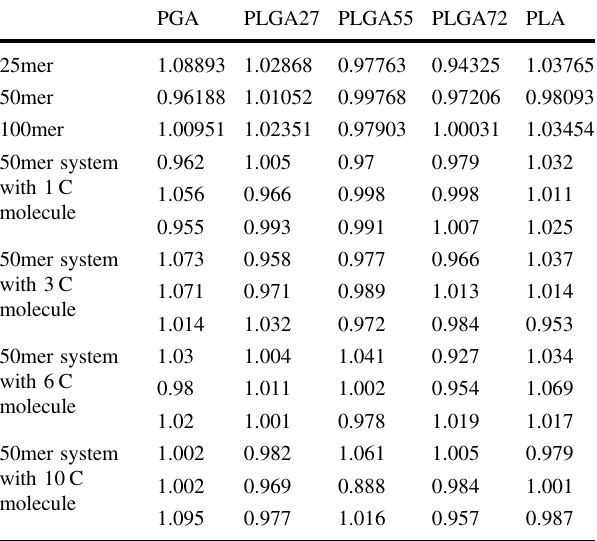
Table 3 R g / R g 0 of polymer chain in the presence of coumarin-6 molecule